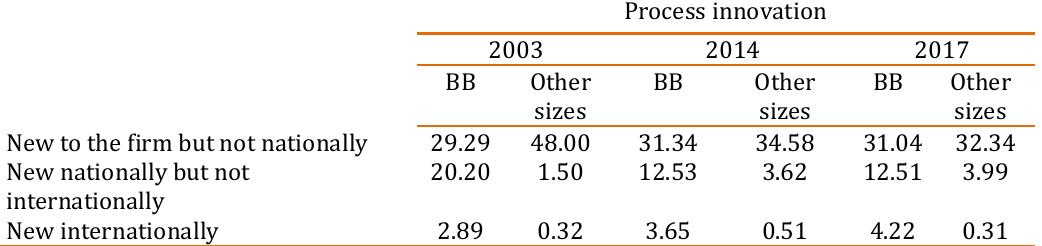
Process innovation 2003 2014 2017 BB Other BB Other BB Other sizes sizes sizes 20.20